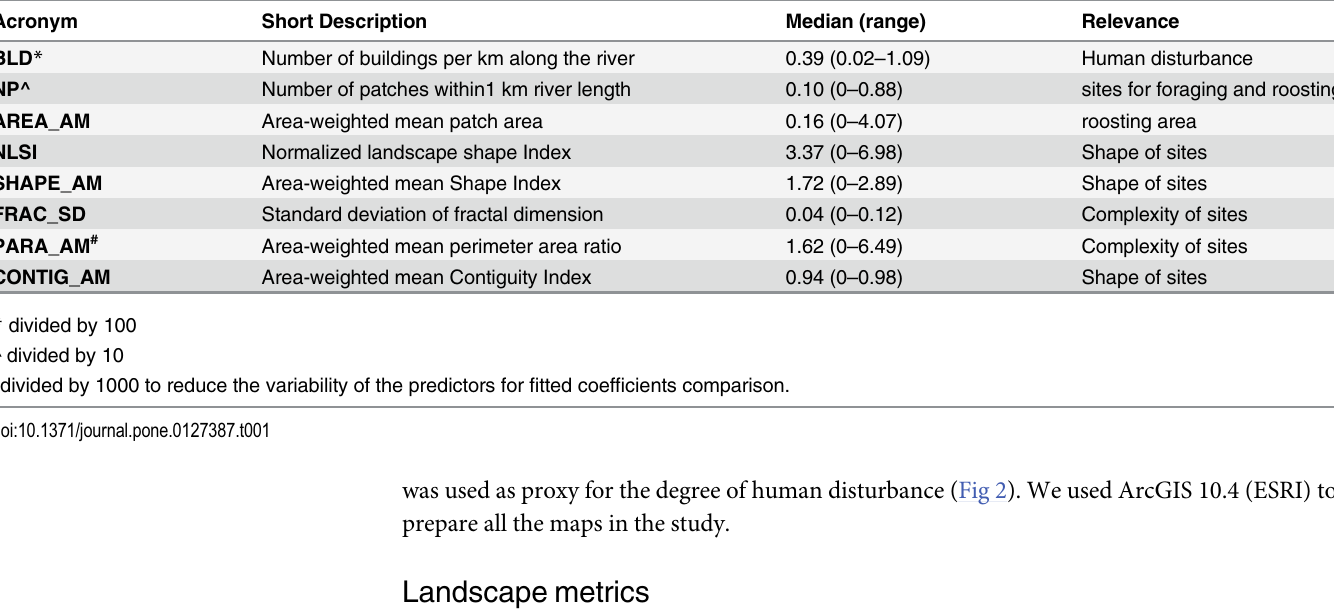
Table 1. Summary of selected candidate predictor variables and their relevance to Scaly-sided Merganser.